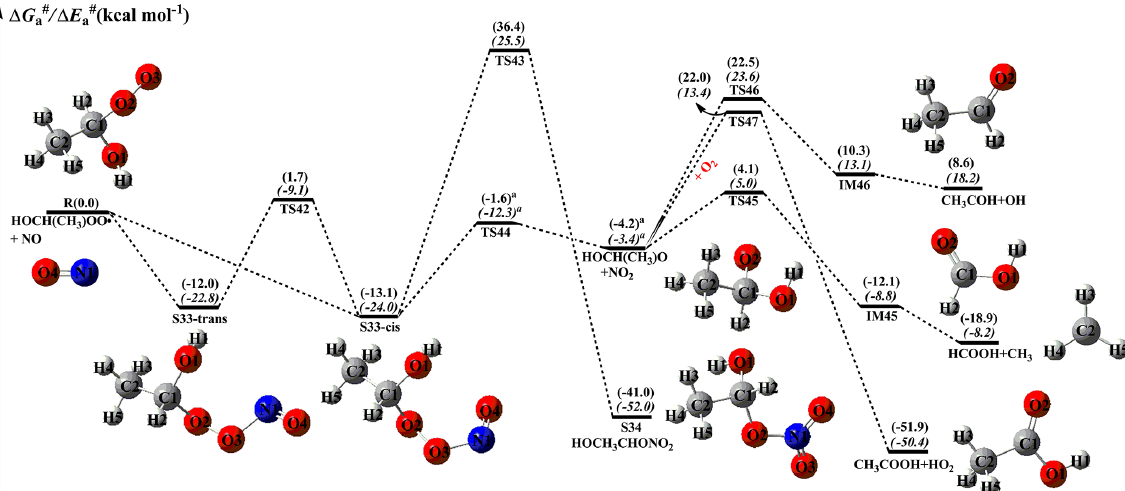
Figure 11. PES ( (cid:49)G # a and (cid:49)E # a , in italics) for the reaction of an HOCH(CH 3 )OO radical with NO predicted at the M06-2X/ma-TZVP//M06- 2X/6-311+G(2df,2p) level of theory (the superscript a is calculated at the MP2/ma-TZVP//MP2/6-311+G(2df,2p)